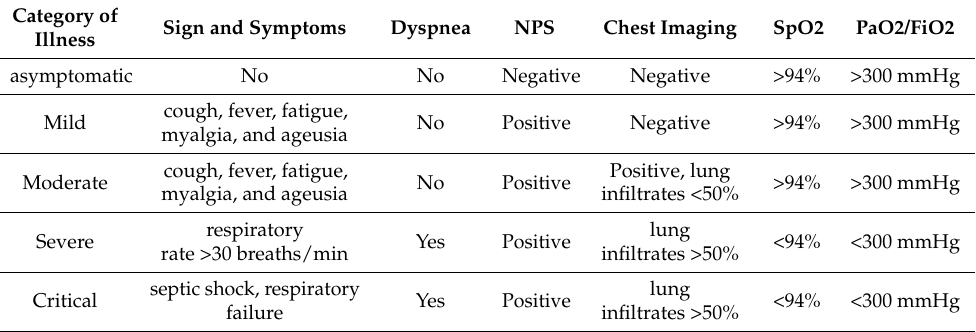
Table 1. Category of patients with SARS-CoV-2 infection. NPS: Naso-pharingeal swab for SARS- CoV-2; SpO2: oxygen saturation; PaO2/FiO2: arterial partial pressure of oxygen/fraction of inspired